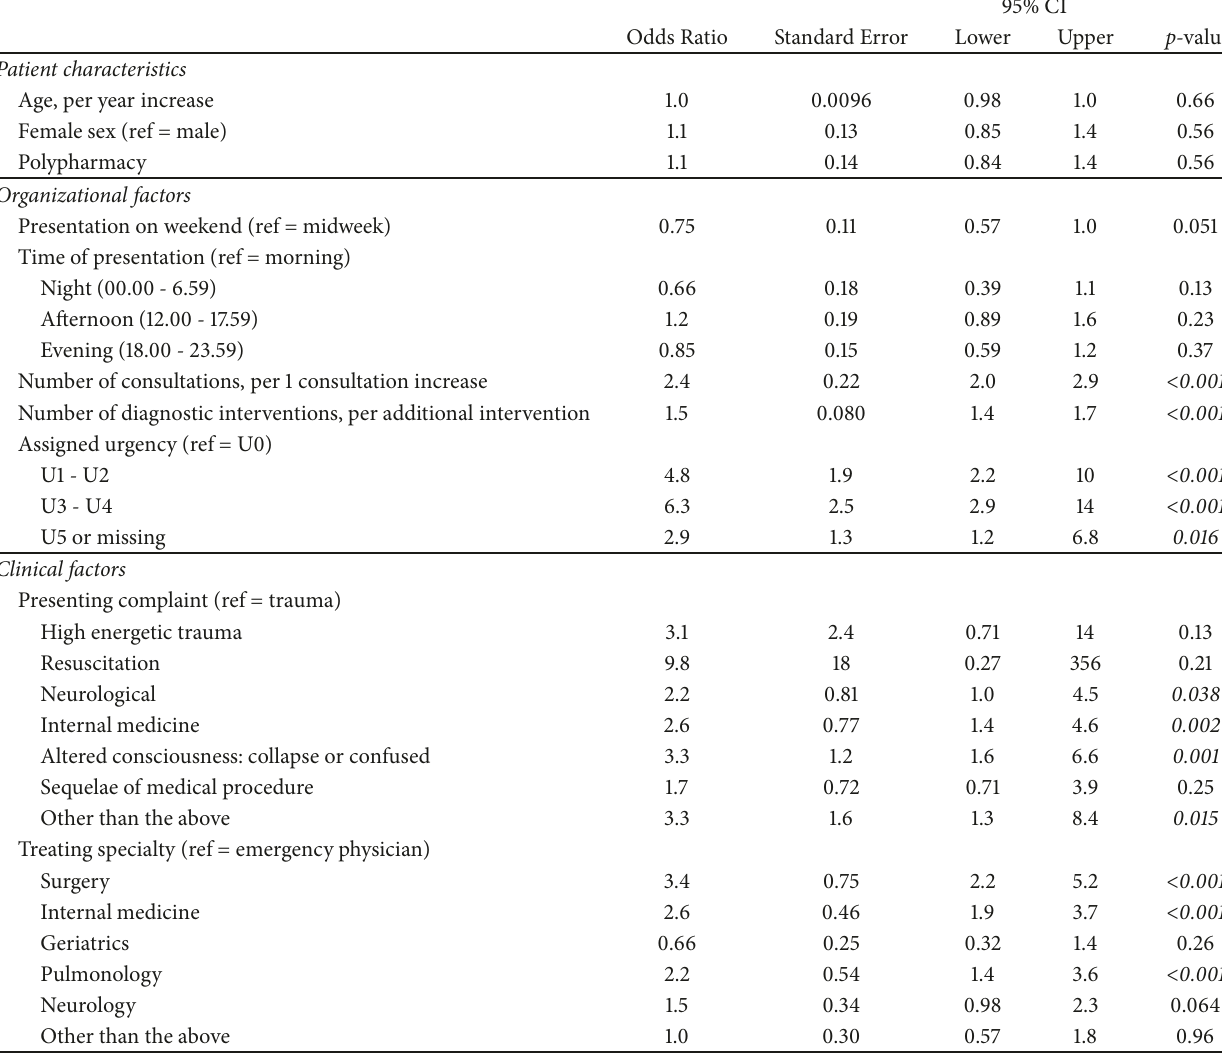
Table 5: Multivariable analysis: independent risk factors for a prolonged LOS (LOS > 293 minutes) at the ED ∗